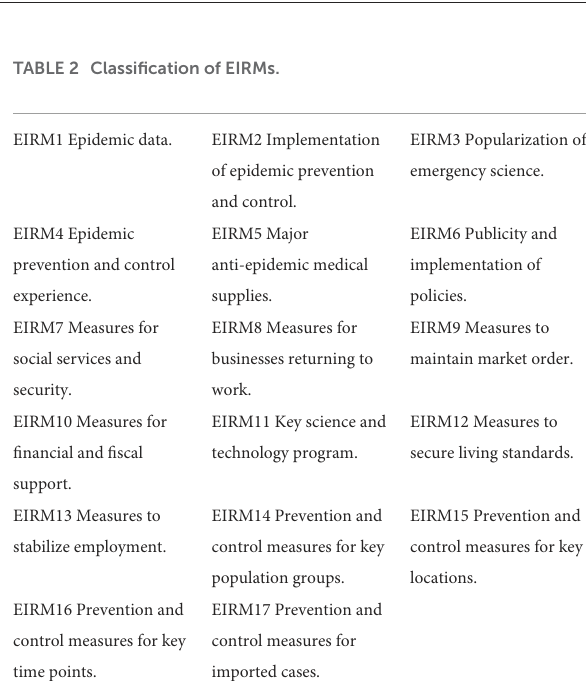
FIGURE1 Research framework of